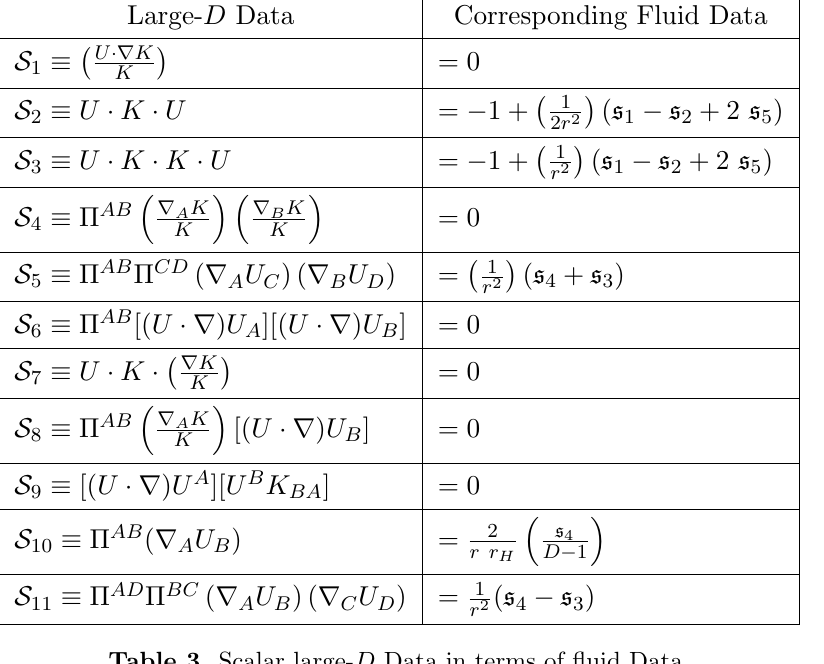
Table 3 . Scalar large- D Data in terms of (cid:13)uid Data.